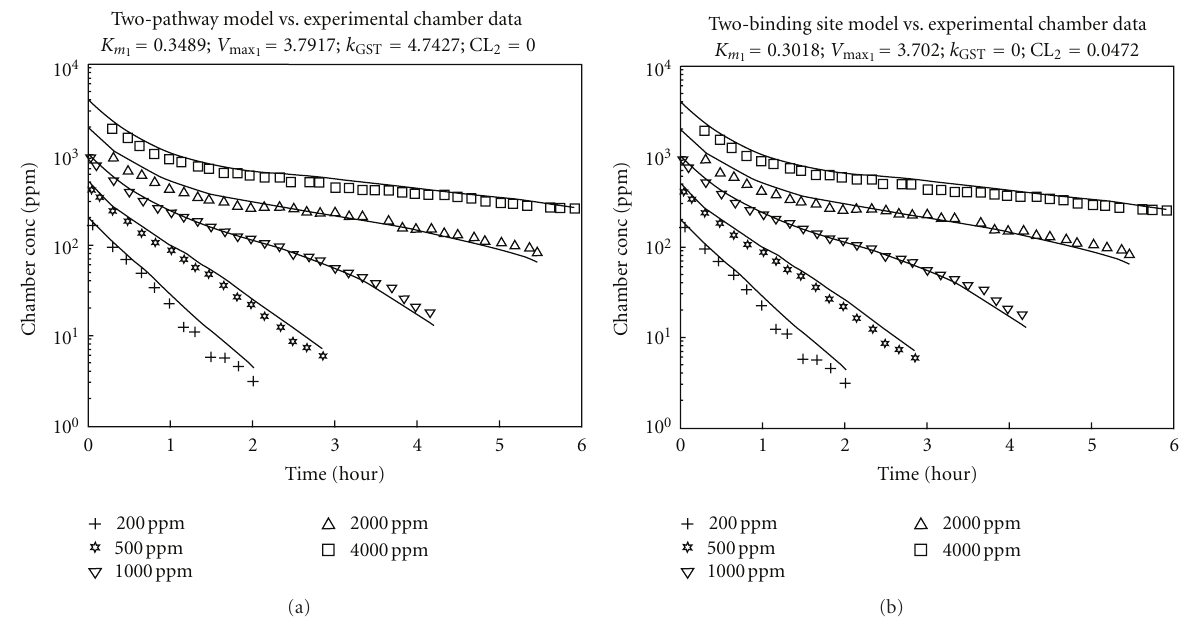
Figure 4: PBPK modeling results using two di ff erent metabolic hypotheses. (a) shows results for the two-pathway model. (b) shows results for the two-binding site model.